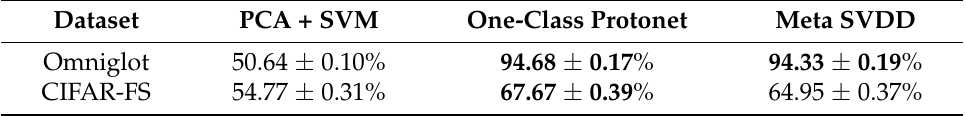
Table 2. Mean accuracy alongside 95% confidence intervals computed over 10,000 tasks for Gaussian kernel One-Class SVM with PCA, Meta SVDD and One-Class Protoypical Networks. The results with highest mean and those with overlapping confidence interval with it are in boldface. We report the best result for the One-Class SVM in its parameter search space, which gives it an advantage over the other two methods. Despite employing a simpler algorithm for one-class classification, One-Class Prototypical networks obtain equivalent accuracy for Omniglot and better accuracy for CIFAR-FS than Meta SVDD. This indicates that learning feature representations is more important than which one-class classification algorithm we